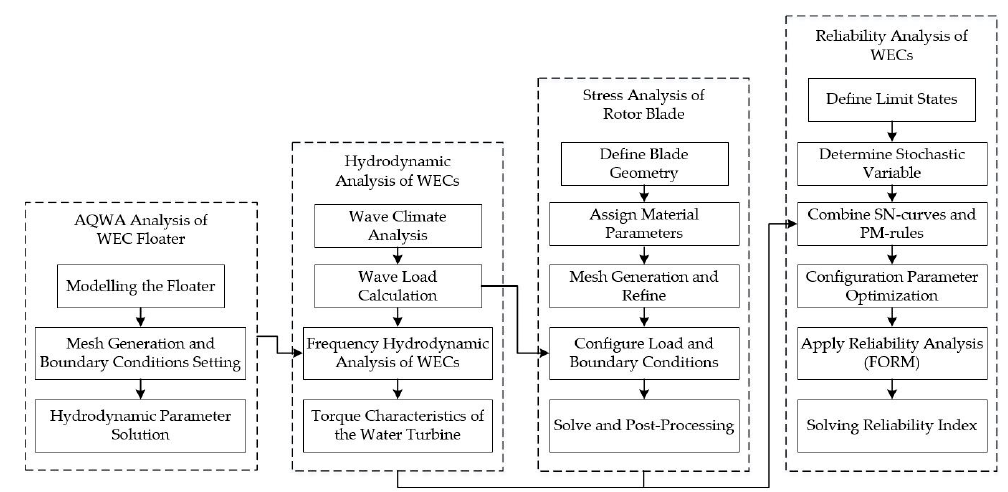
Figure 8. Flowchart of the reliability analysis. Table 10. Structural parameters of the floater.